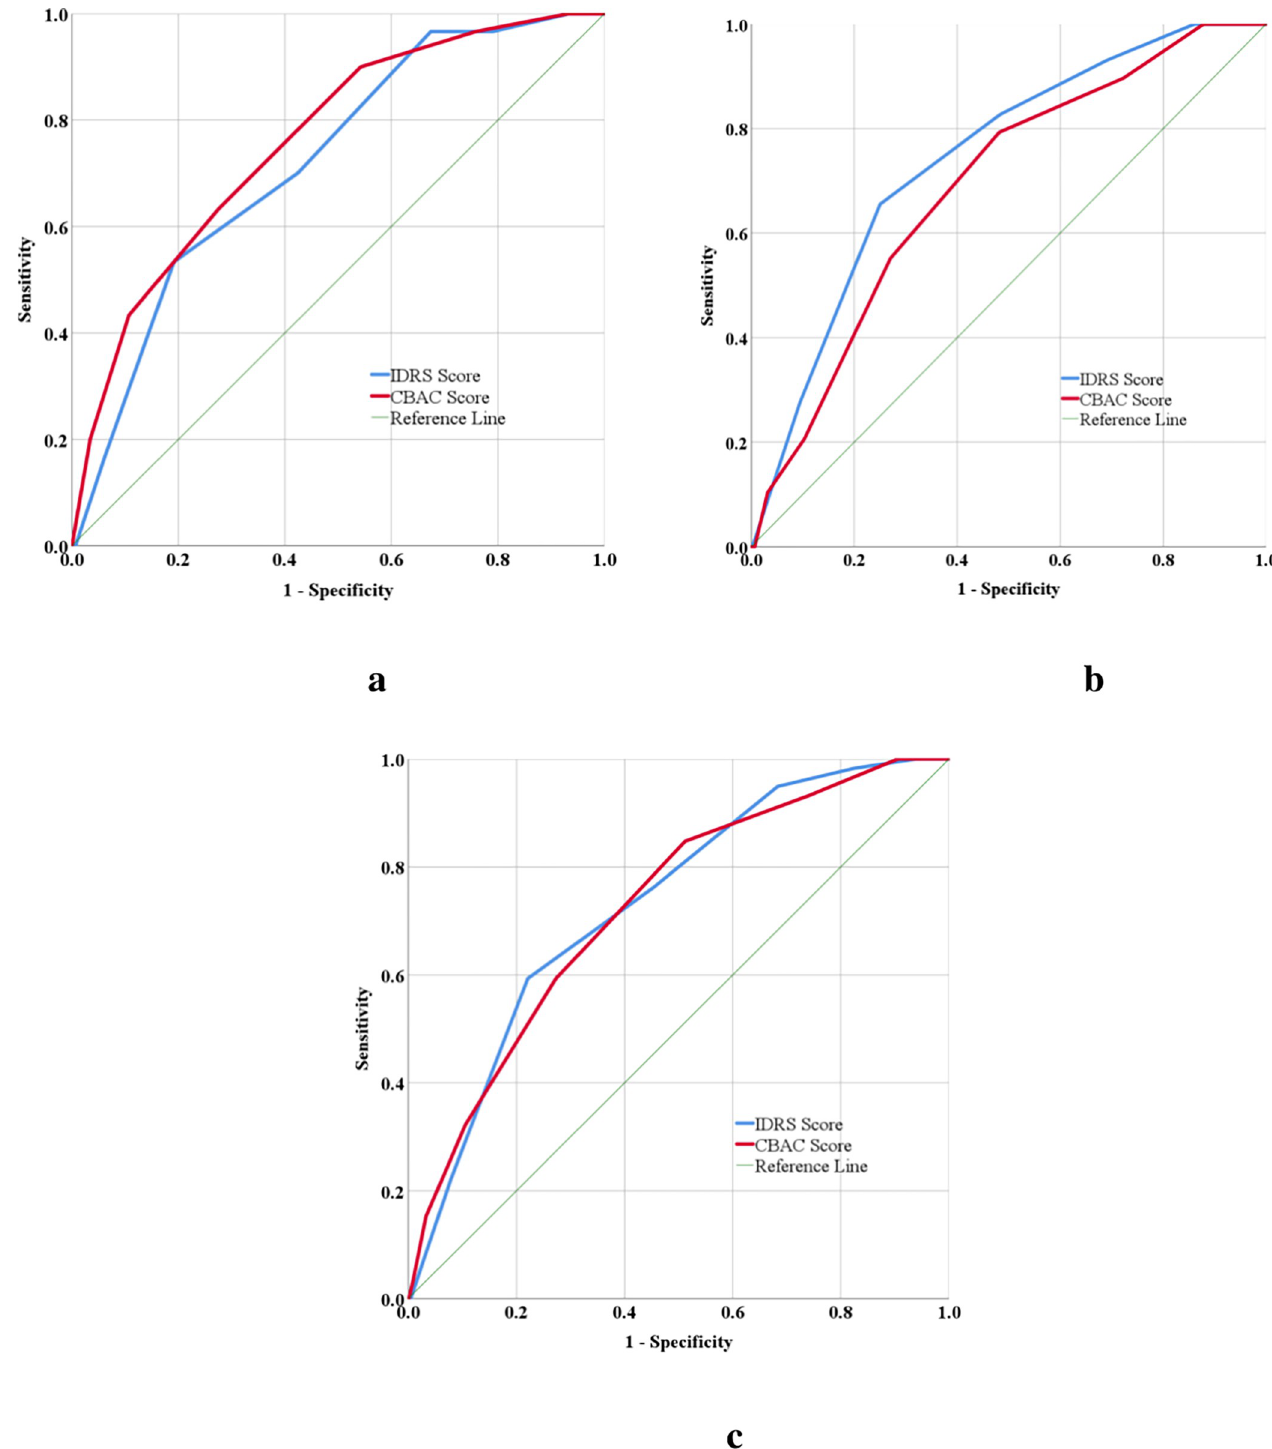
Fig 2. ROC curves for depicting prediction ability of Met S with IDRS and CBAC score for Metabolic Syndrome (2a: ROC curves for Males, 2b: ROC curves for Females, 2c: ROC curves for total participants).